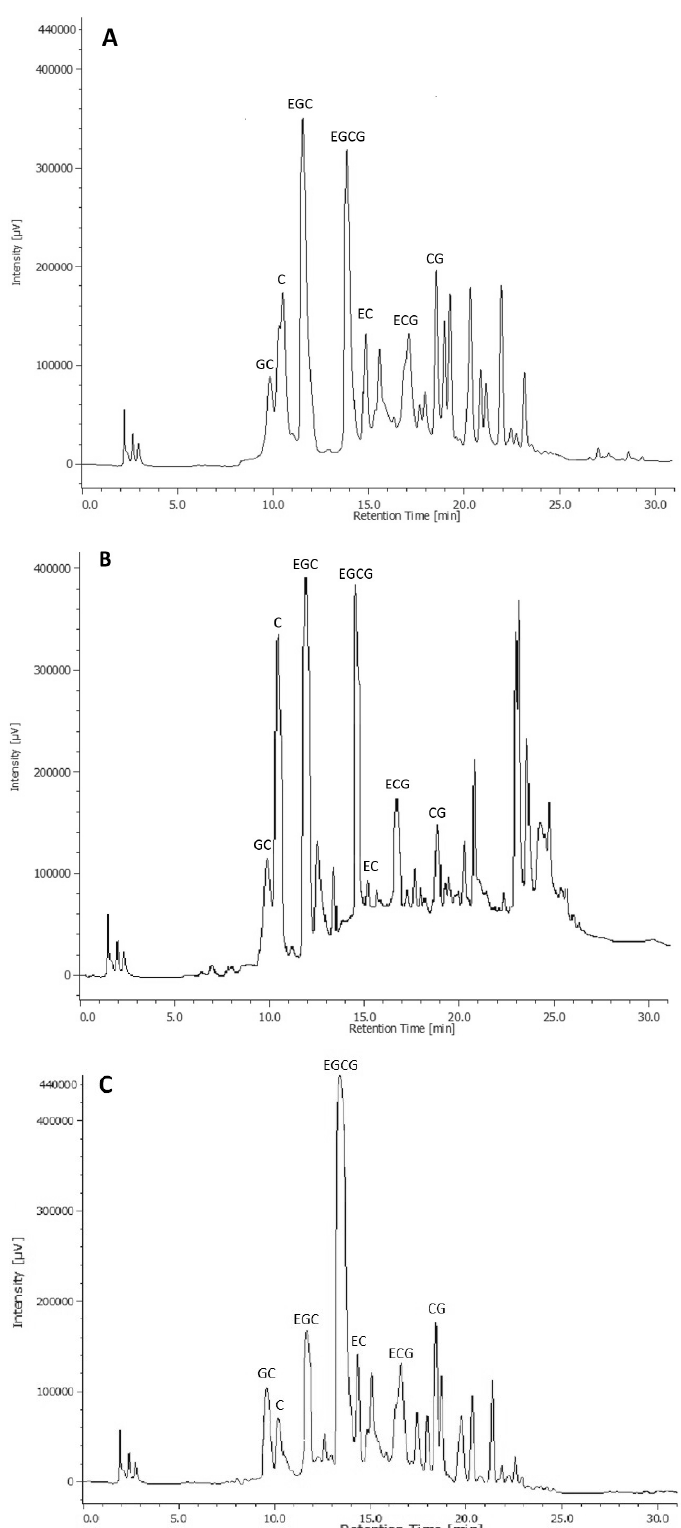
Figure 1. HPLC-diode-array detector (DAD) chromatograms of not digested green tea (GT) ( A ), black tea (BT) ( B ) and white tea (WT) ( C ) with identifying observed catechins. C: (+)-catechin; EC: ( − )-epicatechin; ECG: ( − )-epicatechingallate; EGC: ( − )-epigallocatechin; EGCG: ( − )-epigallocatechingallate; GC: ( − )-gallocatechin; CG: ( − )-catechingallate.